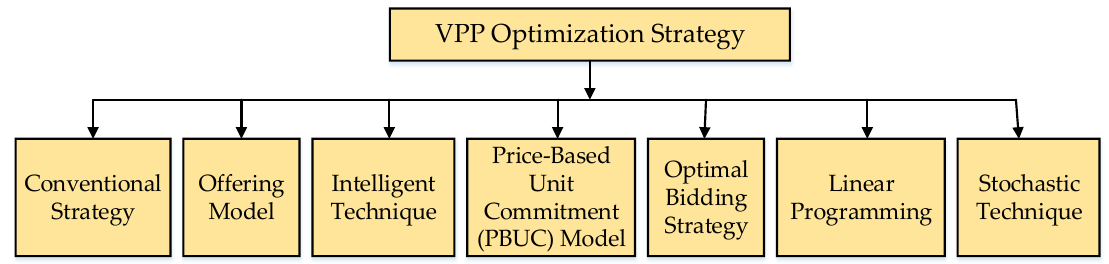
Figure 7. A classification of different optimization strategies for virtual power plants (VPP).